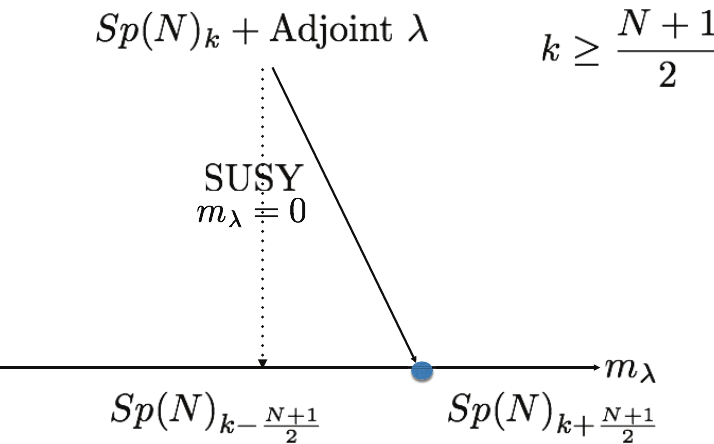
Figure 12: The phase diagram for Sp ( N ) gauge theory with an adjoint fermion for k k ≥ ( N + 1 ) / 2. The physics at the supersymmetric point is smooth. For k = ( N + 1 ) / 2 the negative mass phase is trivial. In that case the transition is still to the right of the supersymmetric